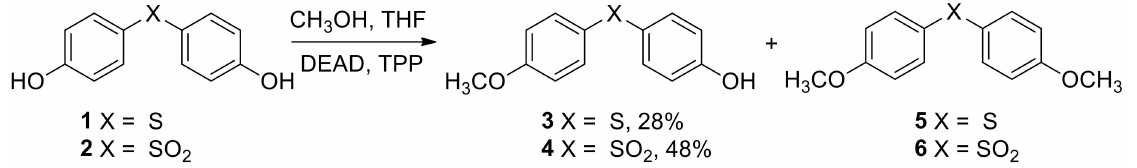
Figure 2. Synthetic route to mono- O -methylated bisphenols 3 and 4